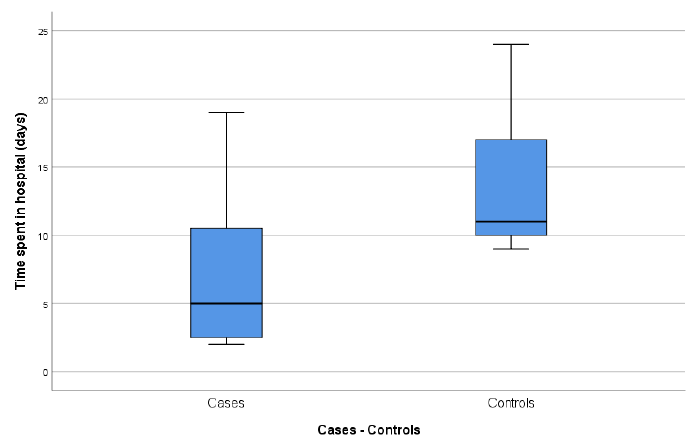
Figure 2. Time spent in the hospital (days).